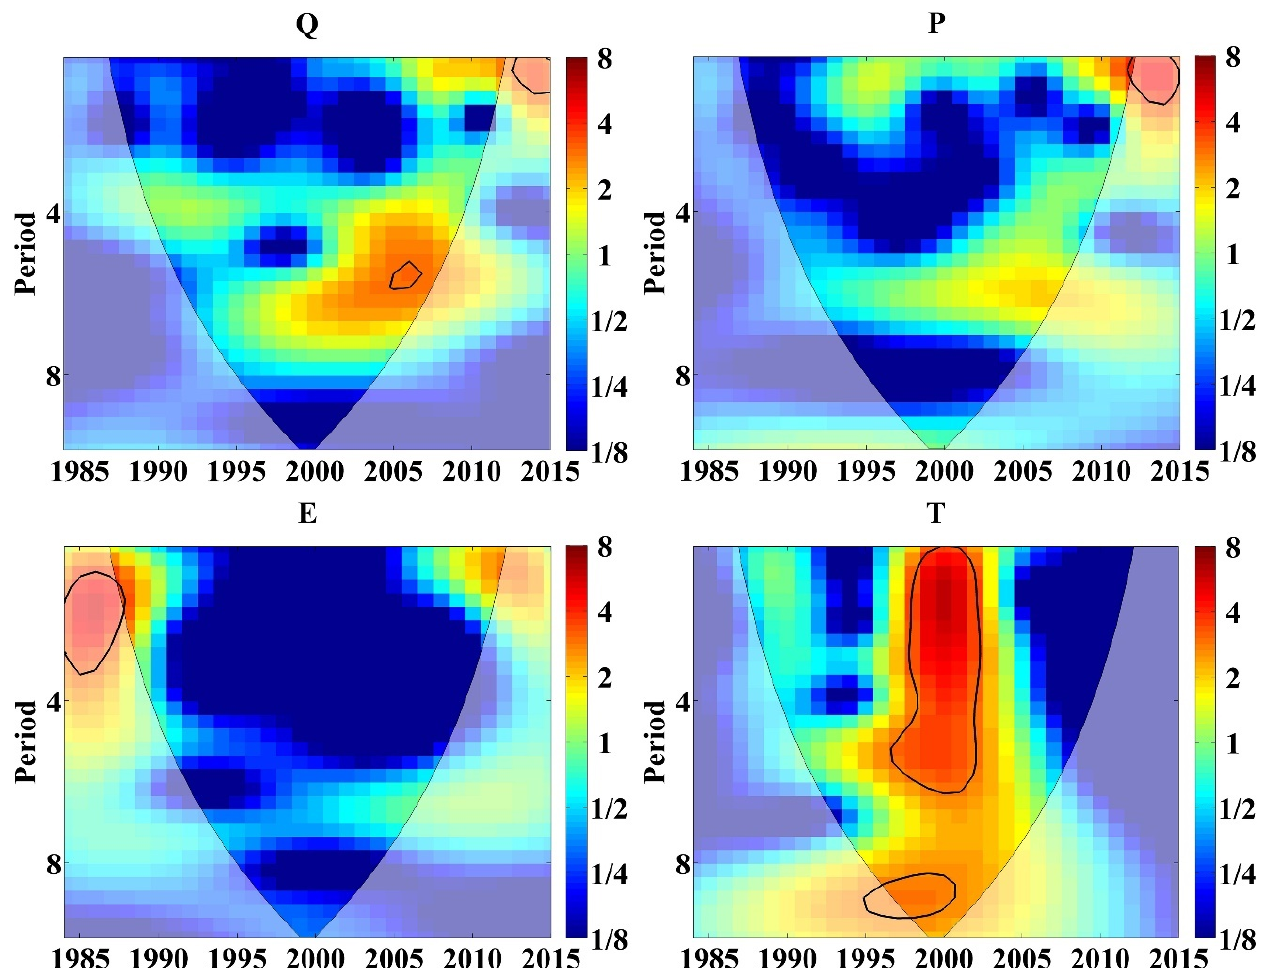
Figure 12. The continuous wavelet power spectra of annual rainfall, evaporation and temperature in Yinjiang River watershed. The thick black contour designates the 5% significance level against red noise and the cone of influence (COI) where edge effects might distort the picture is shown as a lighter shade.